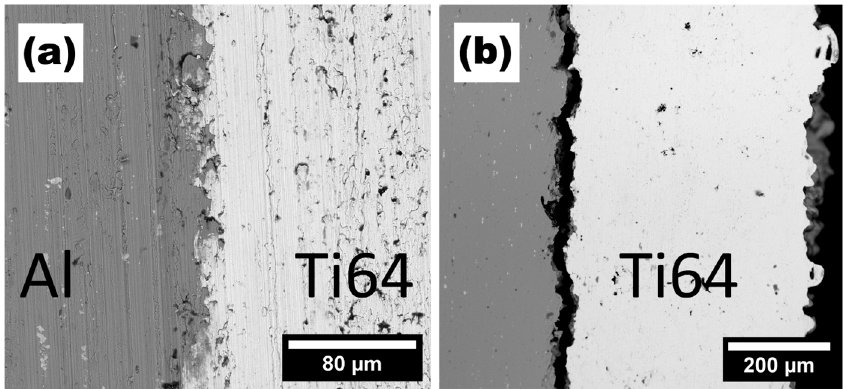
Figure 9. ( a ) Ti64 layer before laser treatment ( b ) Ti64-3 sample after laser